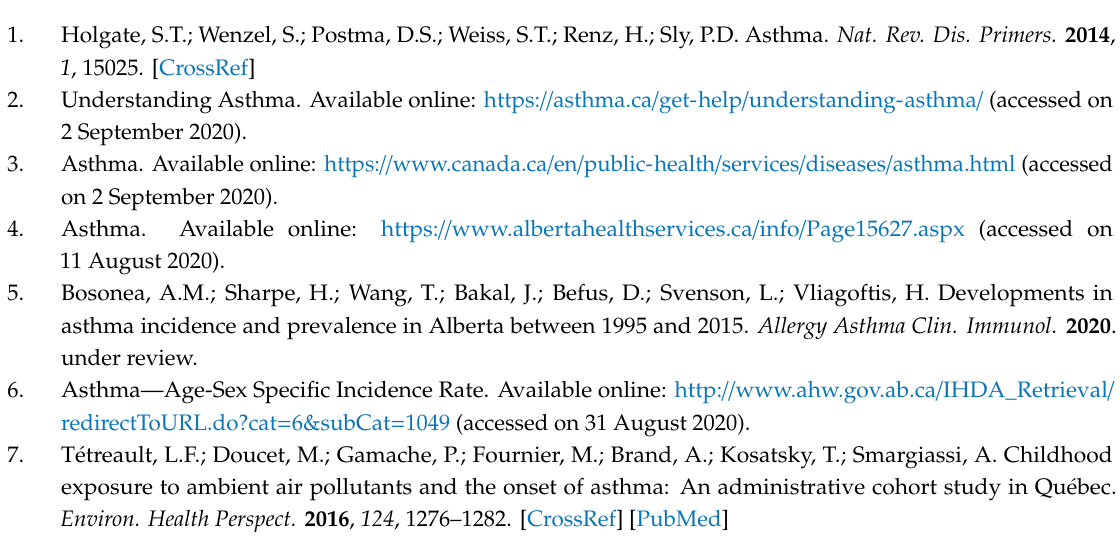
Table S1: Spatial distribution of AEV and AEVR for each year of the study period, Table S2: Regression analysis for AEV2016 on all summer and winter